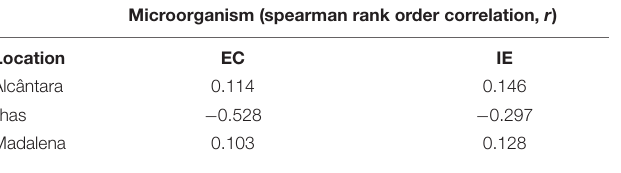
TABLE 2 | Spearman rank order correlation between the levels of precipitation and the concentration of FIB per basin